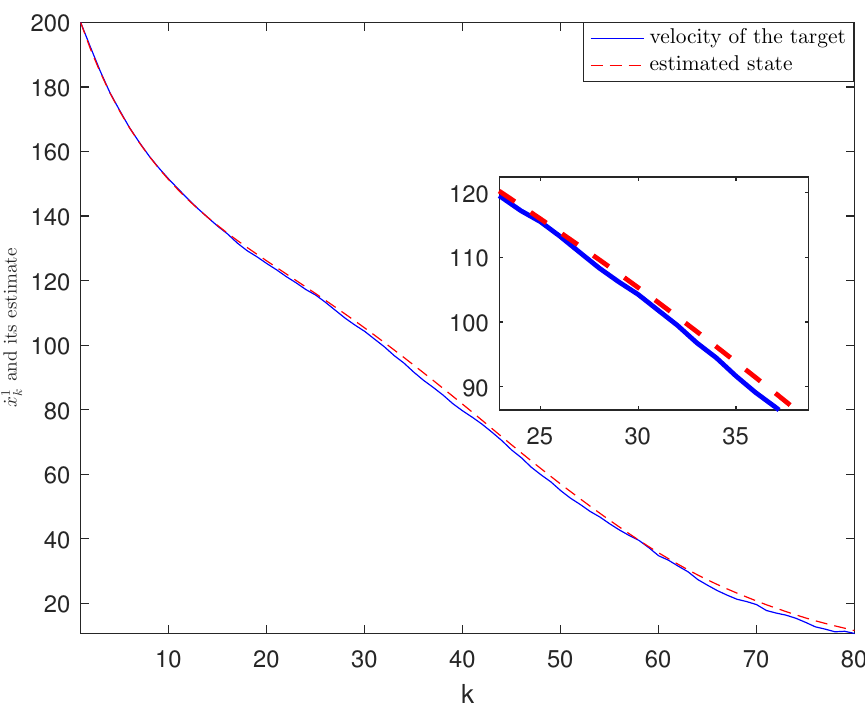
Figure 7. The velocity of the target ˙ x 1, k and its estimate.